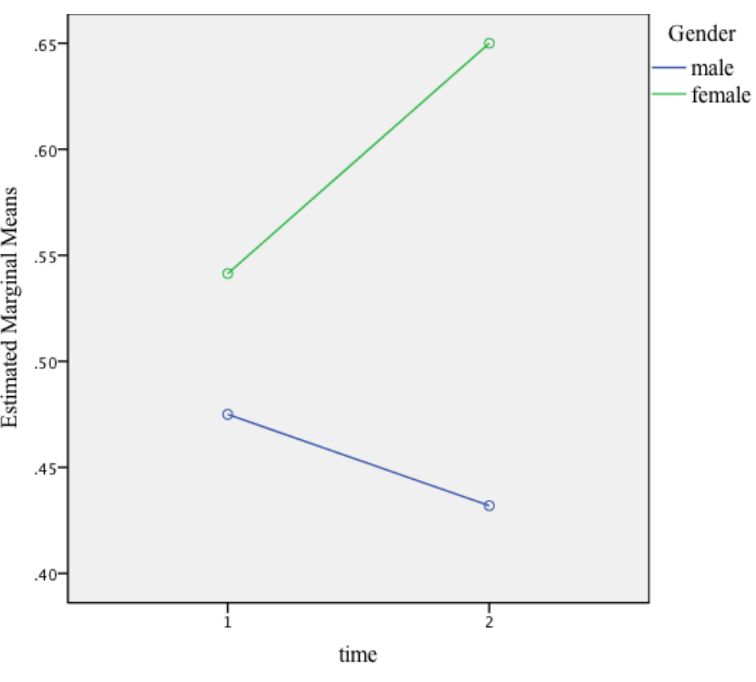
Figure 1 . Percent attempted use of manipulatives Whereas, girls tended to attempt and correctly use manipulative-based strategies more than boys, boys seem to decrease attempted use of these strategies across the first grade while girls increased their attempted use of these strategies. Although boys tended to increase reported performance goals over the school year and girls tended to report a decrease in performance goals, the repeated measure analyses of performance goals with gender as the independent variable indicated no significant differences for time or